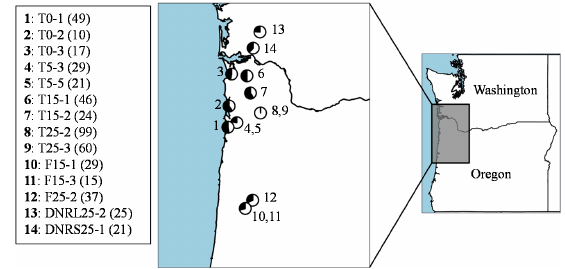
Figure 3. Map showing the relative distributions of two lineages of P. gaeumannii across the 14 sites sampled for this study. Lineage 1 is represented by empty (white) circles, while Lineage 2 is represented by filled (black) circles. The numbers next to each pie chart correspond to the site names in the legend at left, and the numbers in parentheses indicate sample sizes. Lineage proportions from sites 4 and 5, 8 and 9, 10 and 11, respectively, were pooled and displayed as single pie charts to avoid overlap. The primary focus of this investigation was to correlate lineage phylogeography with disease distribution. In this case, climate ( i.e. , temperature and precipitation gradients) may be an important factor influencing the different distribution patterns of the two lineages across the landscape. There is strong evidence that climatic variables such as winter temperature and precipitation in the spring and early summer influence the abundance of P. gaeumannii, and thus disease [22–26]. The western Oregon Coast Range is particularly suited to support abundant populations of P. gaeumannii because it receives greater spring precipitation, and has generally milder winter, and cooler summer, temperatures than the rest of the region. The observed distribution of the lineages observed in this study and others [8,22], may be strongly influenced by seasonal temperatures. Trends in phylogeography also suggest that environmental conditions may limit the distribution of Lineage 2 relative to Lineage 1. One explanation may be that Lineage 2 is better adapted to warmer winter